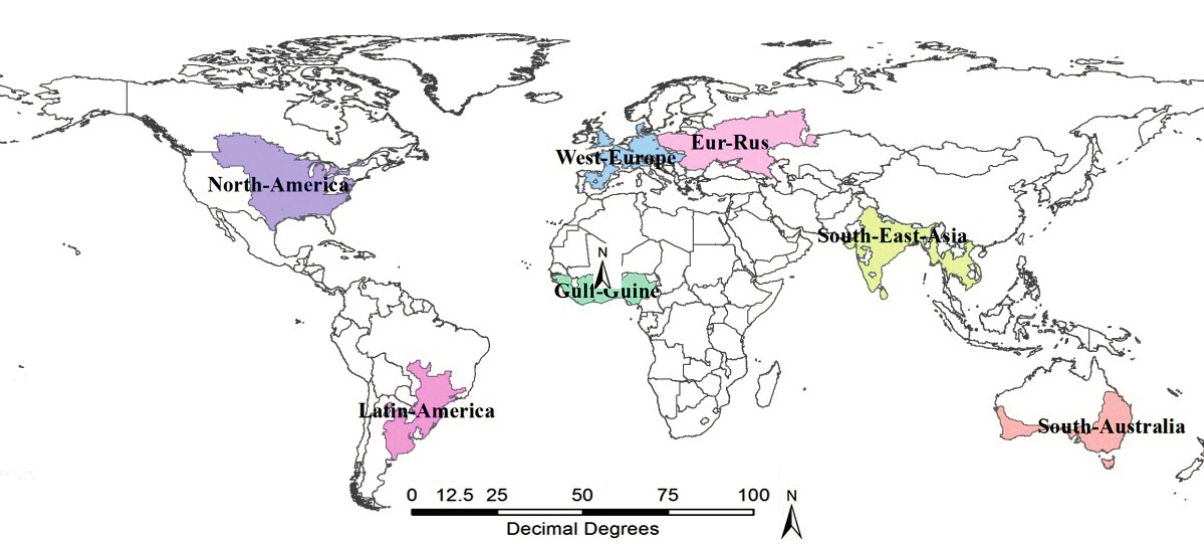
Figure 4. Major Production Zones in the CropWatch